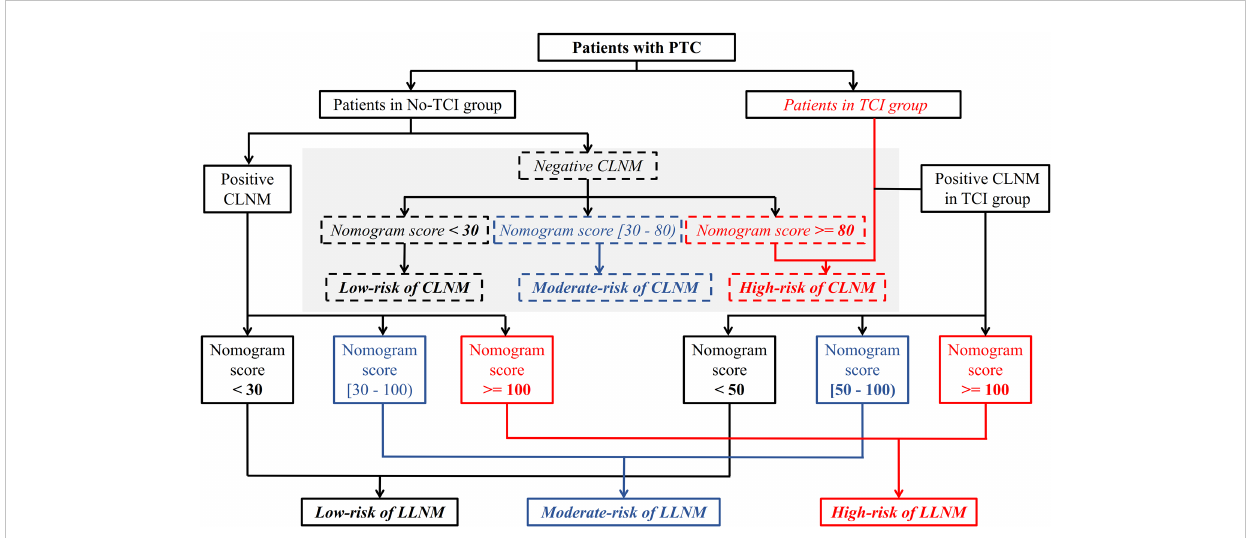
FIGURE 4 A meticulous and comprehensive strati fi cation fl ow chart of cervical lymph node metastasis risk including both CLNM and LLNM for patients with PTC. CLNM, central lymph node metastasis; LLNM, lateral lymph node metastases; PTC, papillary thyroid